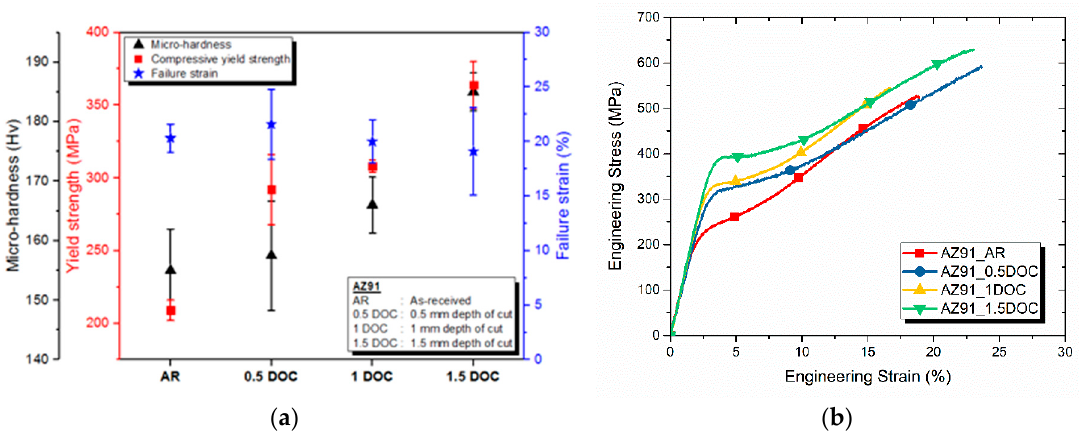
Figure 5. ( a ) Mechanical properties of materials; and ( b ) representative engineering stress-strain curves of the materials.